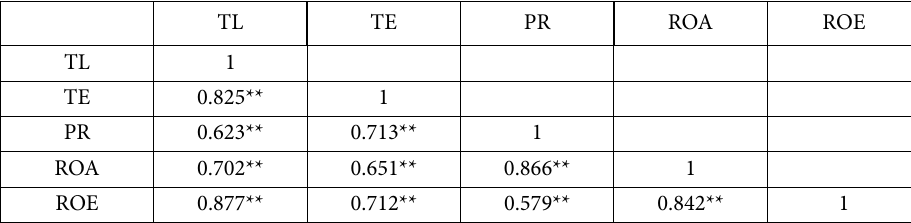
Table 1. The Pearson correlation result